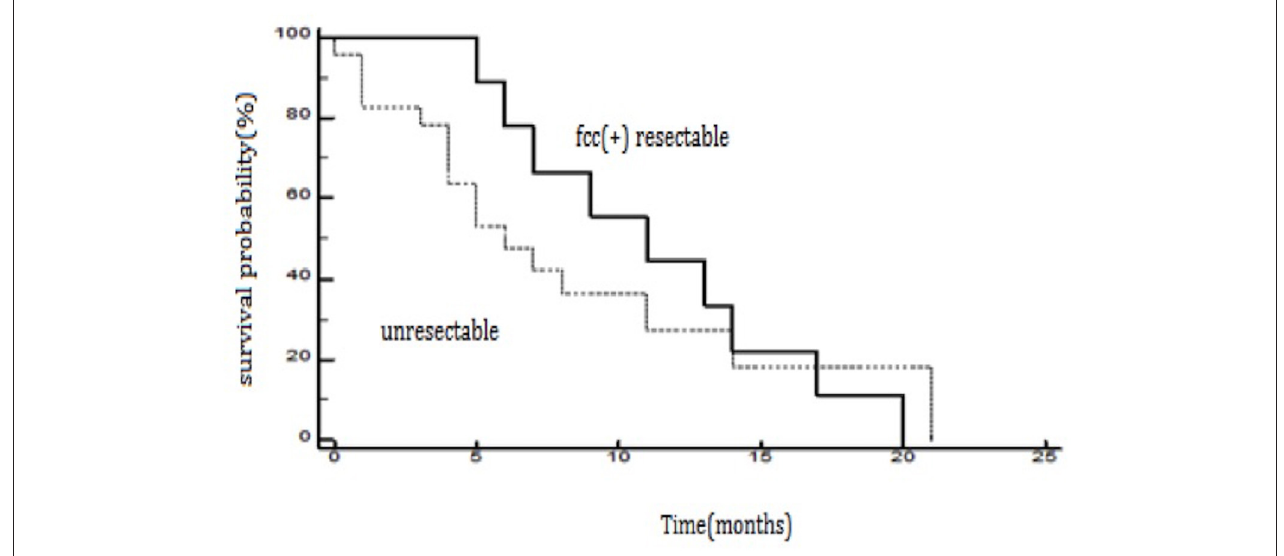
FIGURE 4 | The Kaplan–Meier survival curves for resected patients from the fcc ( + ) group and non-resected patients from the fcc ( + ) and fcc (–) group ( p = 0.47).